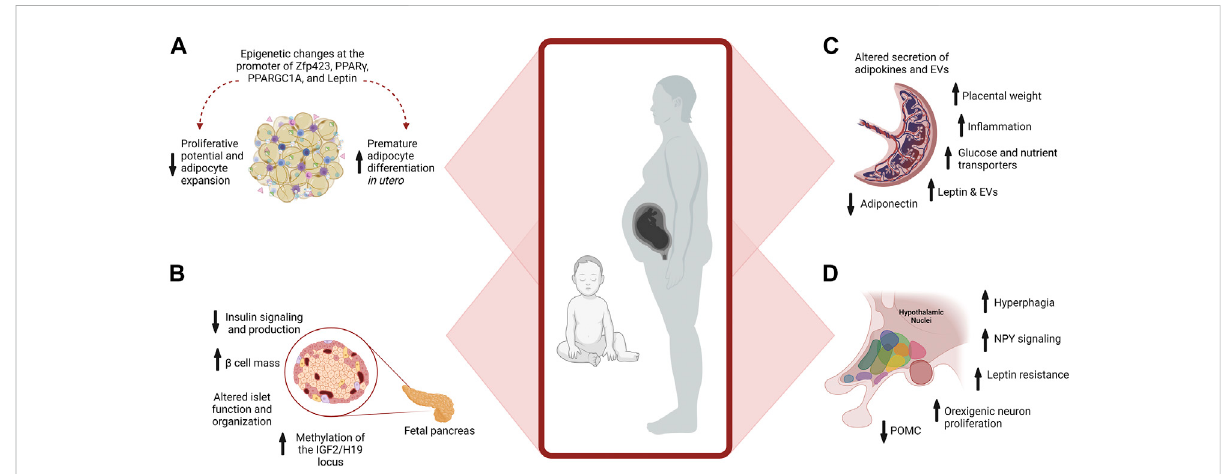
FIGURE 3 Maternal Obesity Alters Placenta, Adipocyte, and β cell Development. (A) Maternal obesity promotes premature differentiation of adipocytes, whichdepletesprogenitorsavailableforexpansioninadulthoodwhenexcessenergystoragemaybeneeded.Epigeneticchangesatthepromoterof multiple genes further affect developmental plasticity. (B) Pancreatic development is in fl uenced by maternal obesity. Exposure to hyperinsulinemia during fetal development increases Islet size and β cell mass, reducing insulin signaling and production. Epigenetic changes also occur, such as increasedmethylationof IGF2 inthepancreas,in fl uencinggrowthandfunction. (C) Intheplacenta,maternalobesityalterstheplacentalsecretionof adipokines and EVs, increases in fl ammation, and placental weight, and modi fi es nutrient transport to the developing fetus. (D) Overfeeding postnatally alters hypothalamic circuits and food